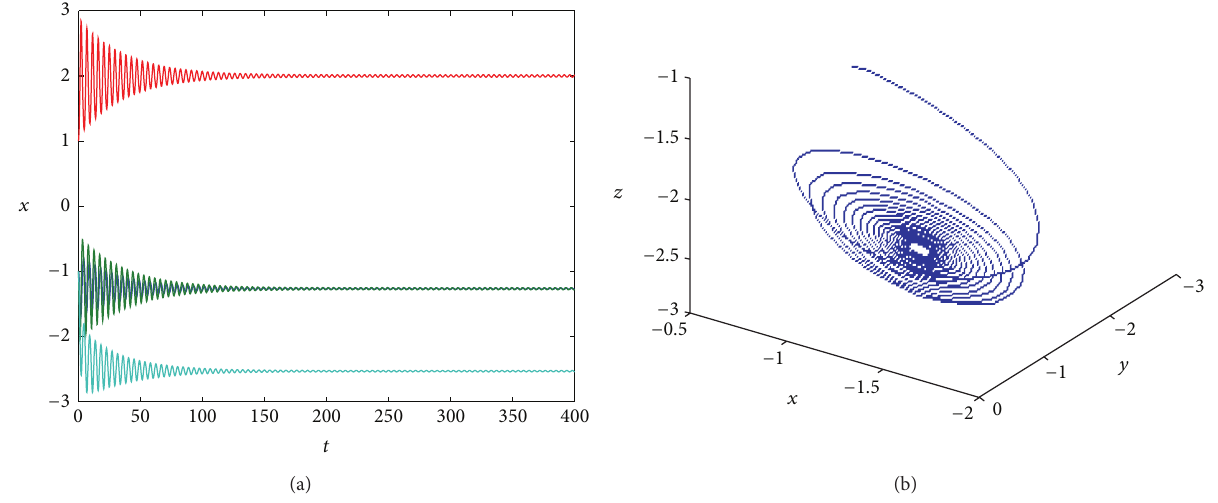
Figure 12: Time history and phase diagram of system (16) with 𝑎 = 1 , 𝑏 = 2 , 𝑚 = 0.5 , 𝑘 1 = 0.2 , 𝑘 2 = 0.5 , and 𝑐 = 0.8 .